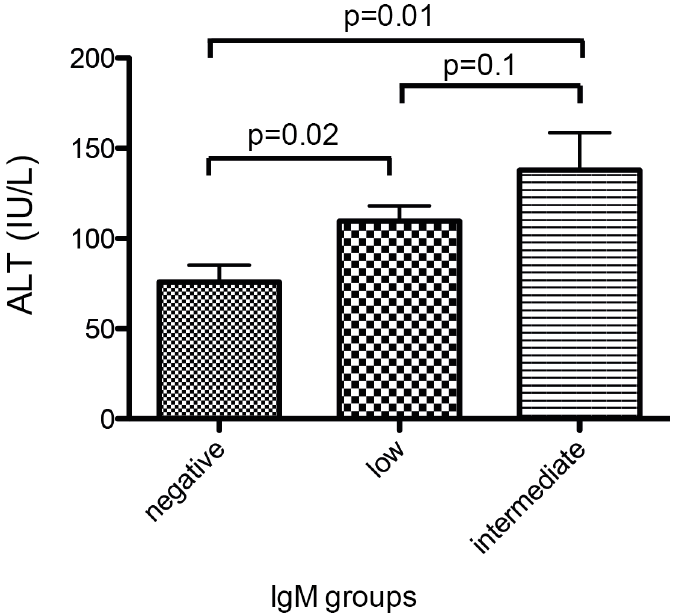
Figure 2. Distribution of ALT values according to Anti-HDV IgM categories in the HIDIT-2 cohort. ALT values were significantly associated with the different anti-HDV IgM groups based on univariate ANOVA (p=0.04) and univariate T- test in the HIDIT-2 cohort.